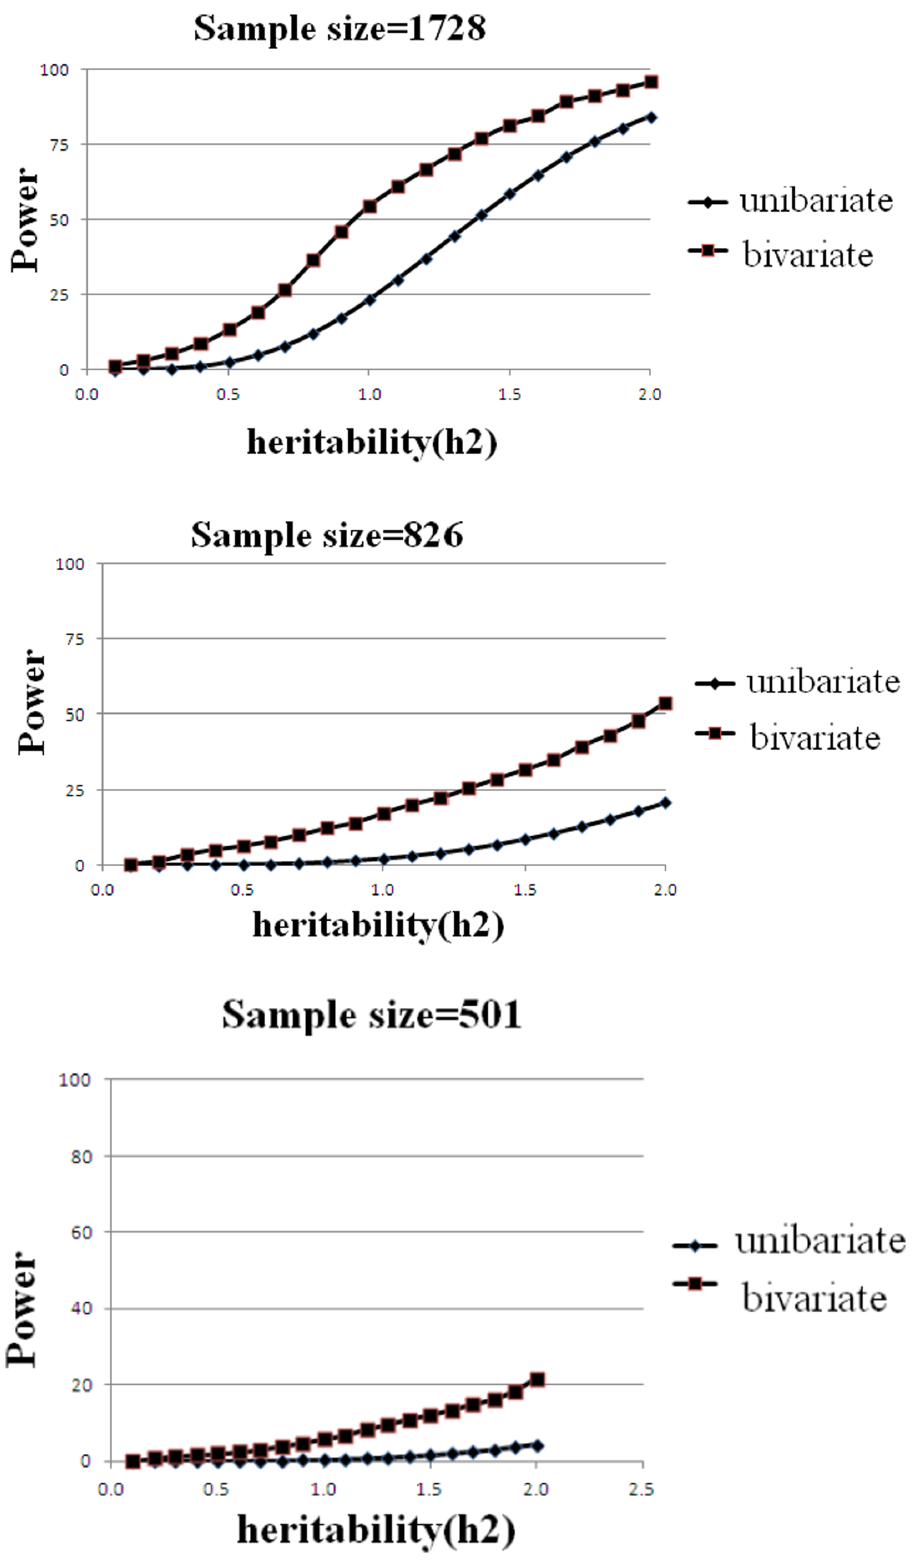
Figure 1. Comparison of statistical power of bivariate vs. univariate association analyses in three samples of this study. The Y axis shows the expected power, and the X axis shows the heritability. Type 1 error was set at 0.05 and minor allele frequency (MAF) was set at 0.1. The sample sizes were 1728 (discovery Caucasians), 826 (replication Chinese) and 501 (replication Caucasians), respectively.